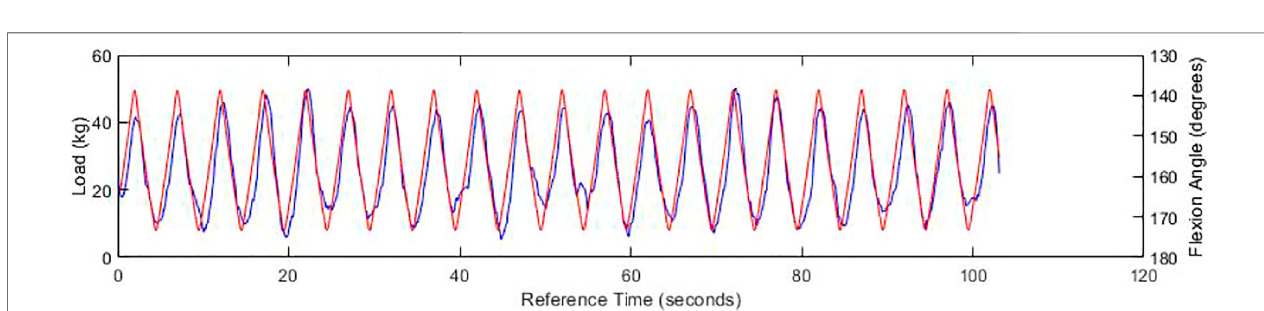
Frontiers in Robotics and AI |